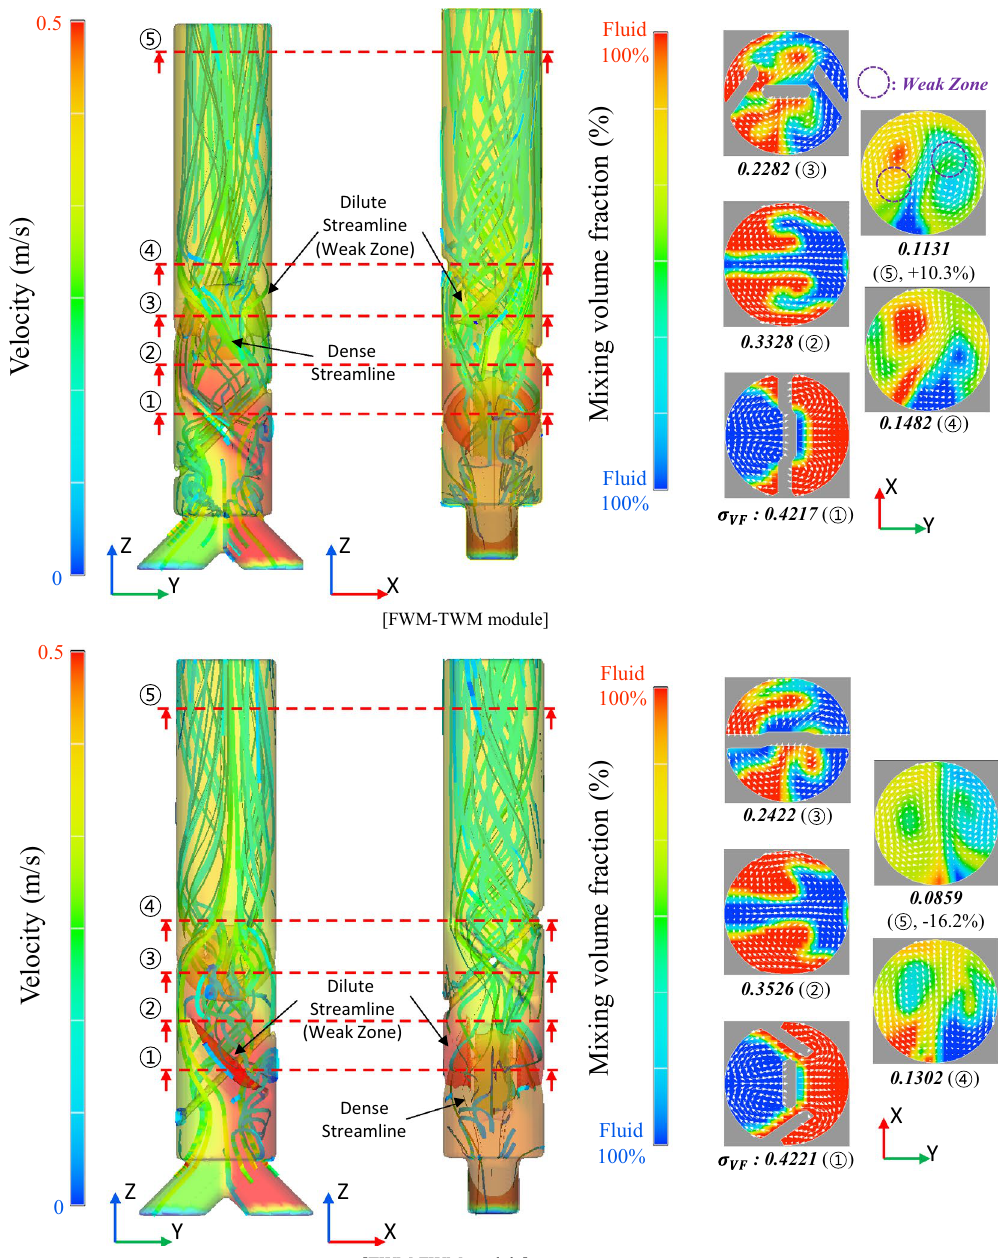
Figure 4. Streamlines and mixing performance of FWM-TWM (combination of with FWM unit at the front and TWM unit at the back) module and TWM-FWM module; transverse direction flow occurs in the TWM unit. Therefore, by placing the TWM unit at the rear, the mixing performance increases by 16% in the mixer with the TWM-FWM